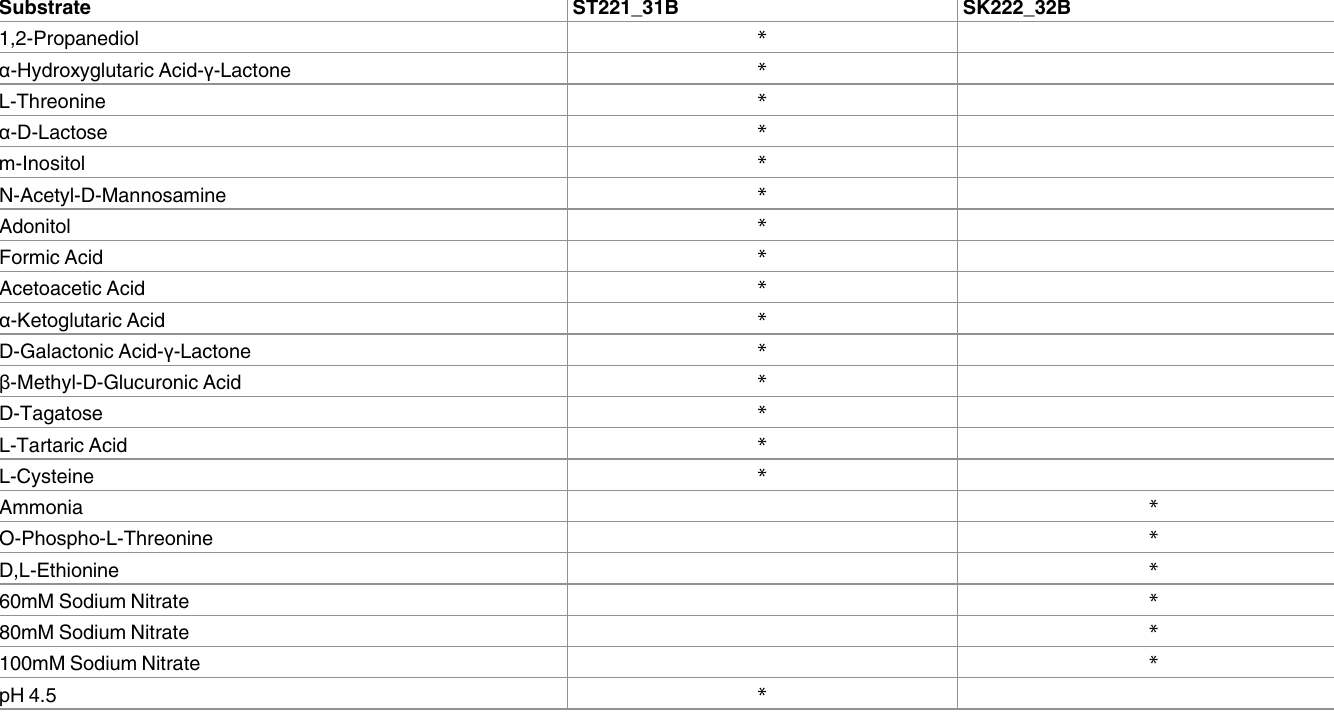
Table 3. Phenotypic microarraysubstrate